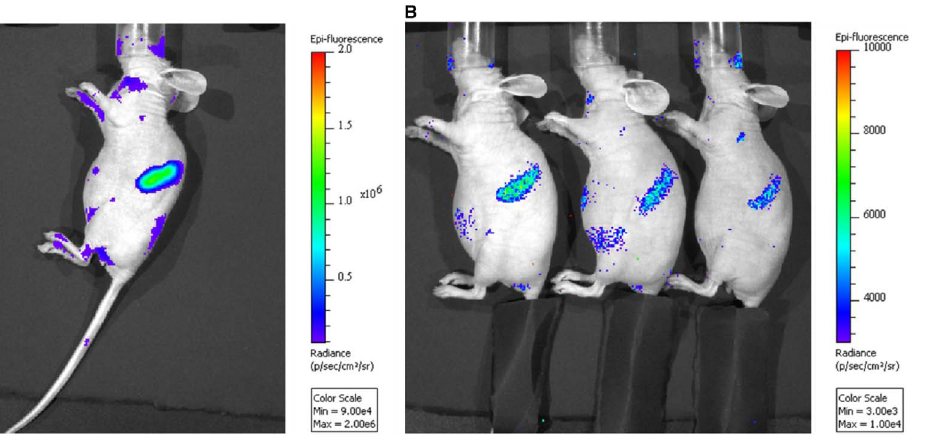
Figure 3. Cerenkov Imaging. Five female athymic mice per imaging group were injected with either A ) 0.3 mCi of 90 Y-DOTA-30F11 or B ) 0.3 mCi 177 Lu- DOTA-30F11 and imaged 24 hours after injection, using a Xenogen IVIS Spectrum imaging platform under 2.5% isoflurane. Differences in the intensity of splenic activity between the mice that received the two isotopes may be attributed to differences in the decay energies of their emitted b 2 particles; note the different scales used in each